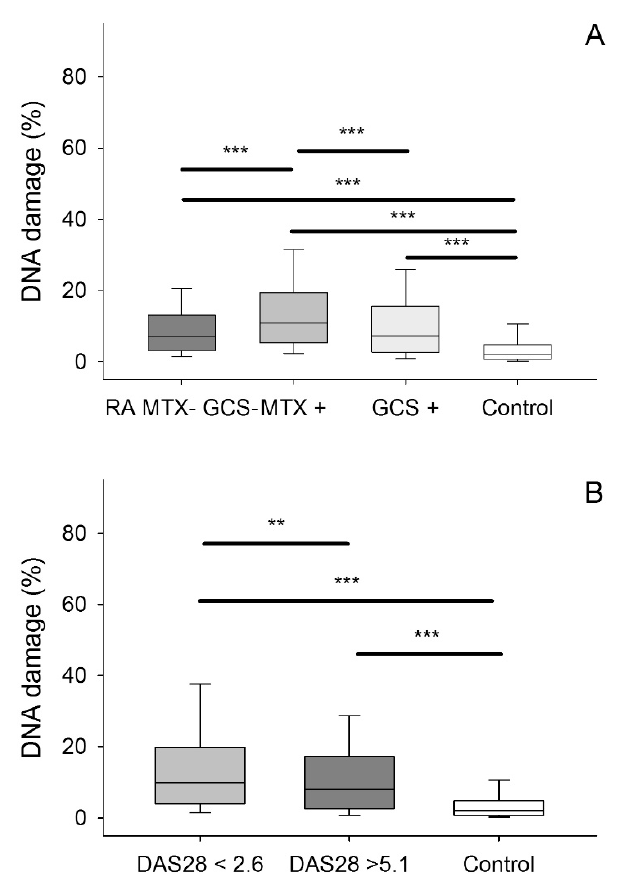
Figure 3. Subclinical analysis of the endogenous DNA lesion level in peripheral blood mononuclear cells (PBMCs) isolated from rheumatoid arthritis (RA) patients. ( A ) Treatment with disease modifying anti-rheumatic drugs such as methotrexate (MTX + , dark grey, n = 10) as well as glucocorticosteroids (GCS + , light grey, n = 7) increased the basal endogenous DNA damage level in comparison to RA without treatment (MTX − , GCS − , grey, n = 2). However, the basal endogenous DNA damage level in PMBCs isolated from non-treatment patients was greater than the basal endogenous DNA damage level in PMBCs isolated from healthy subjects (Control, white, n = 20). ( B ) The RA exacerbation had no impact on basal endogenous DNA damage level in PMBCs isolated from RA patients. The RA exacerbation was presented by the Disease Activity Score 28-joint count (DAS28) parameter. Patients with high disease activity were defined as DAS28 higher than 5.1 (dark grey, n = 6); whereas patients with low disease activity or remission were defined as DAS28 < 2.6 (grey, n = 5). White box means control. DNA damage was measured as the percentage of DNA in the tail in the alkaline version of the comet assay. The value of cells scored for each individual was 100. The di ff erences between two groups were analyzed using the Mann–Whitney rank sum test. Di ff erences between more than two groups were analyzed using an ANOVA on ranks test following all pairwise multiple comparison procedures (Dunn’s method). Analysis, *** means p < 0.001, **